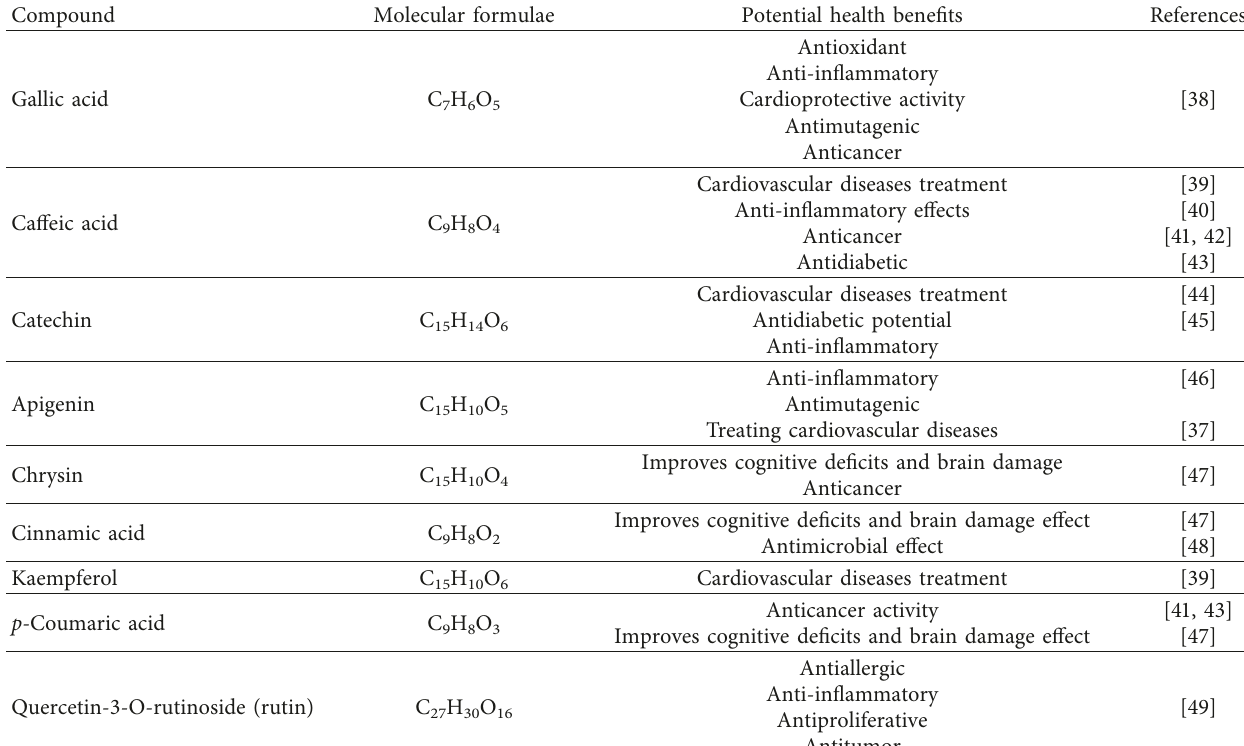
Table 2: Common phenolic compounds with their potential health benefits found in both European bee honeys and stingless bee honeys.